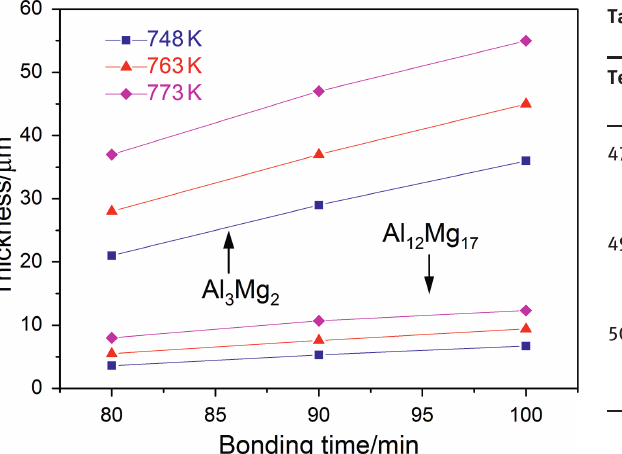
Figure 9: The selected area XRD results from the joint interface.